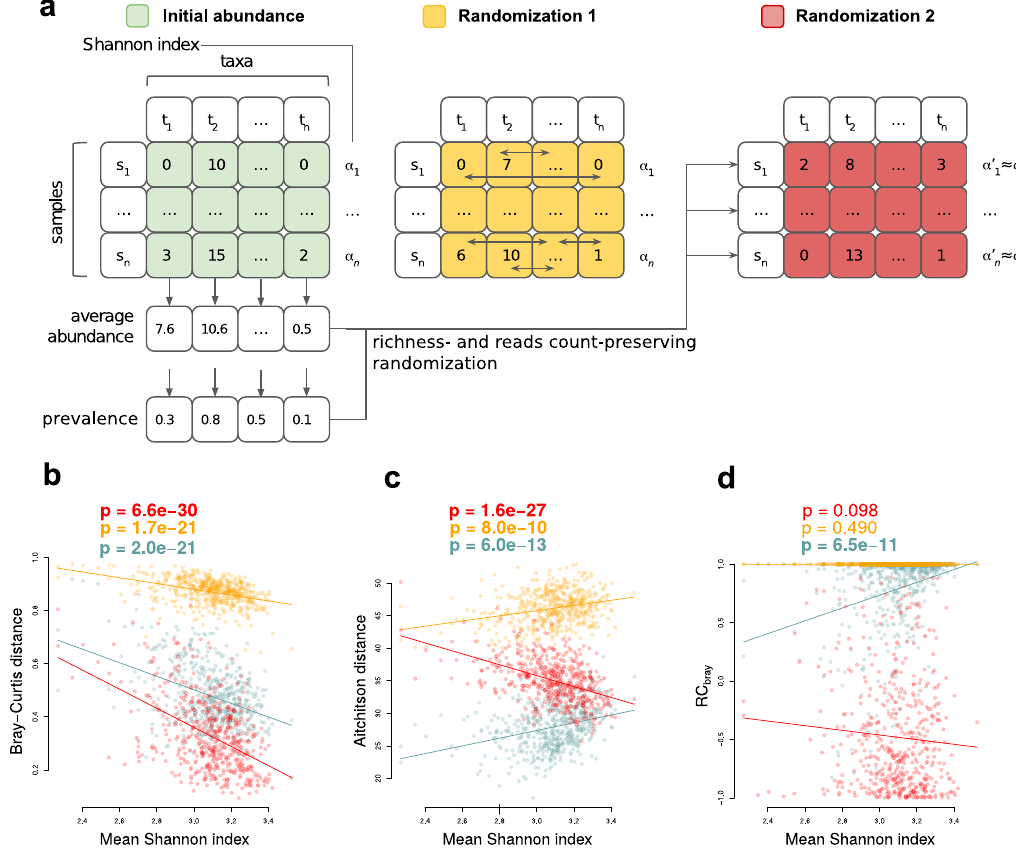
Fig. 1 Investigation of computational components in the relationship between alpha and beta diversity. a Scheme of the two randomisation strategies (see Methods), b – d Relationship between average alpha diversity and beta diversity calculated for the 500 random pairs of samples from the FGFP cohort ( p values obtained using linear regression). The colours denote initial data and data randomised by the two strategies (see legend for panel a ). Alpha diversity was assessed via the Shannon metric, while beta diversity - via Bray – Curtis ( b ), Aitchison ( c ) and RC bray ( d )